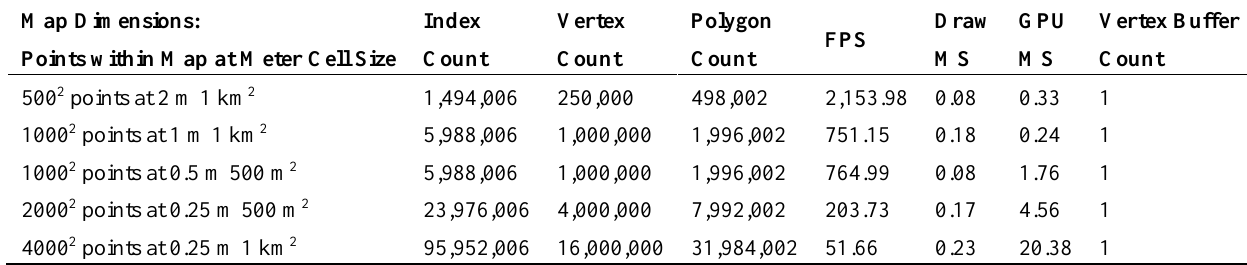
Table 4. Runtime evaluation of visualised terrains at multiple resolutions with single vertex buffers. Only one map is visualised within each scene. The data is captured while the 3D camera is pointing to the centre of the scene, containing all terrain